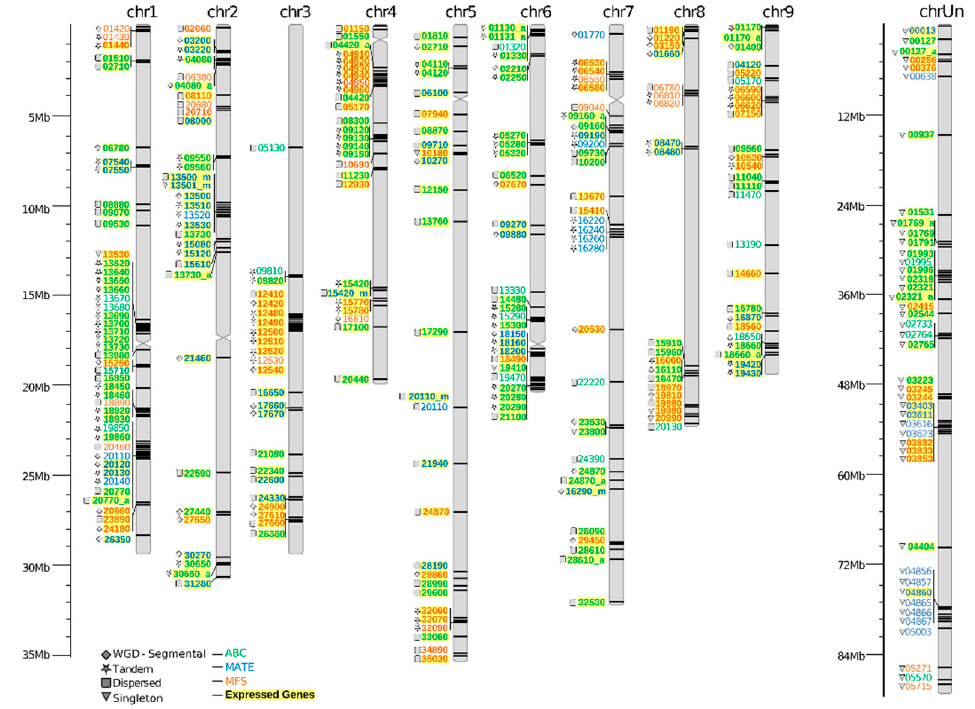
Figure 1. Genome distribution and gene duplication events of multi-antimicrobial extrusion protein (MATE), ATP-binding cassette transporters (ABC), and major facilitator superfamily (MFS) genes from C. sinensis . The size of a chromosome is indicated by its relative length given in Mb. Chromosome numbers (Chr) are indicated at the top of each chromosome. Gene duplication events are indicated with symbols. Genes with transcriptomic evidence from the citrus reference transcriptome under Xanthomonas citri subsp. citri (Xac) infection were shaded using yellow color and bold letters. The C. sinensis unplaced chromosome (chrUn) was not considered in the comparative genome analyses.